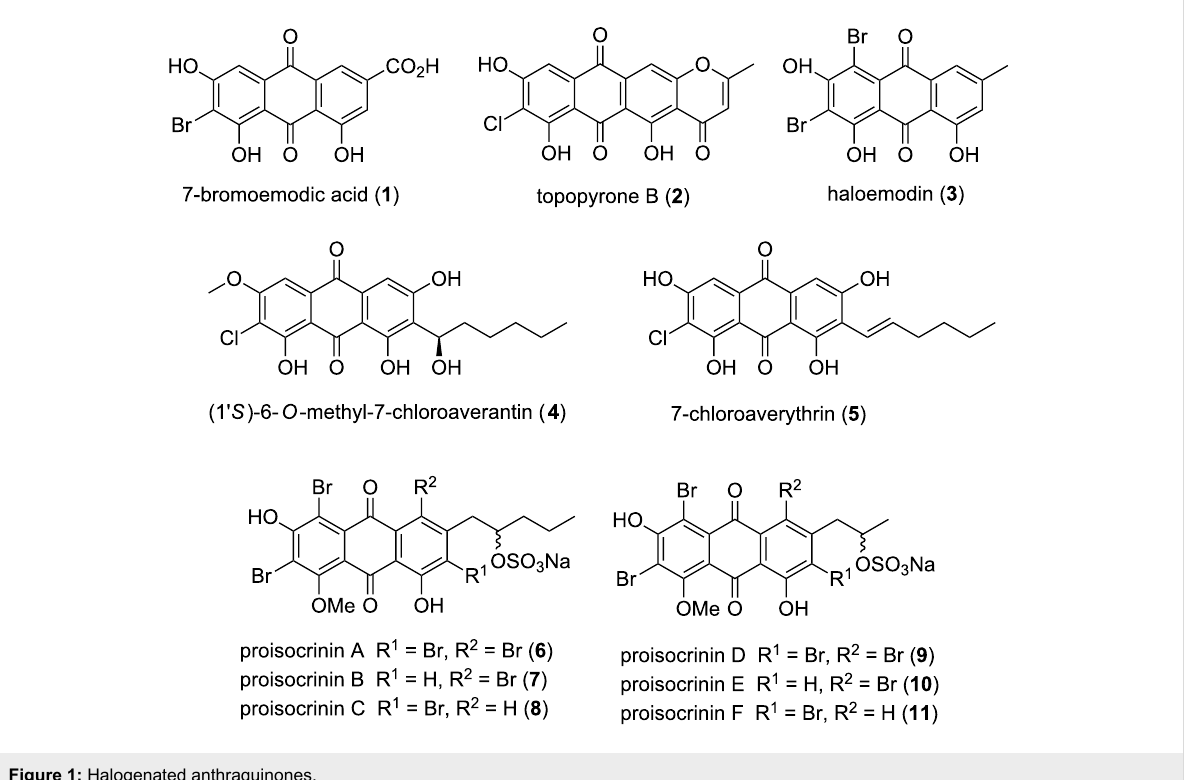
Figure 1: Halogenated anthraquinones.